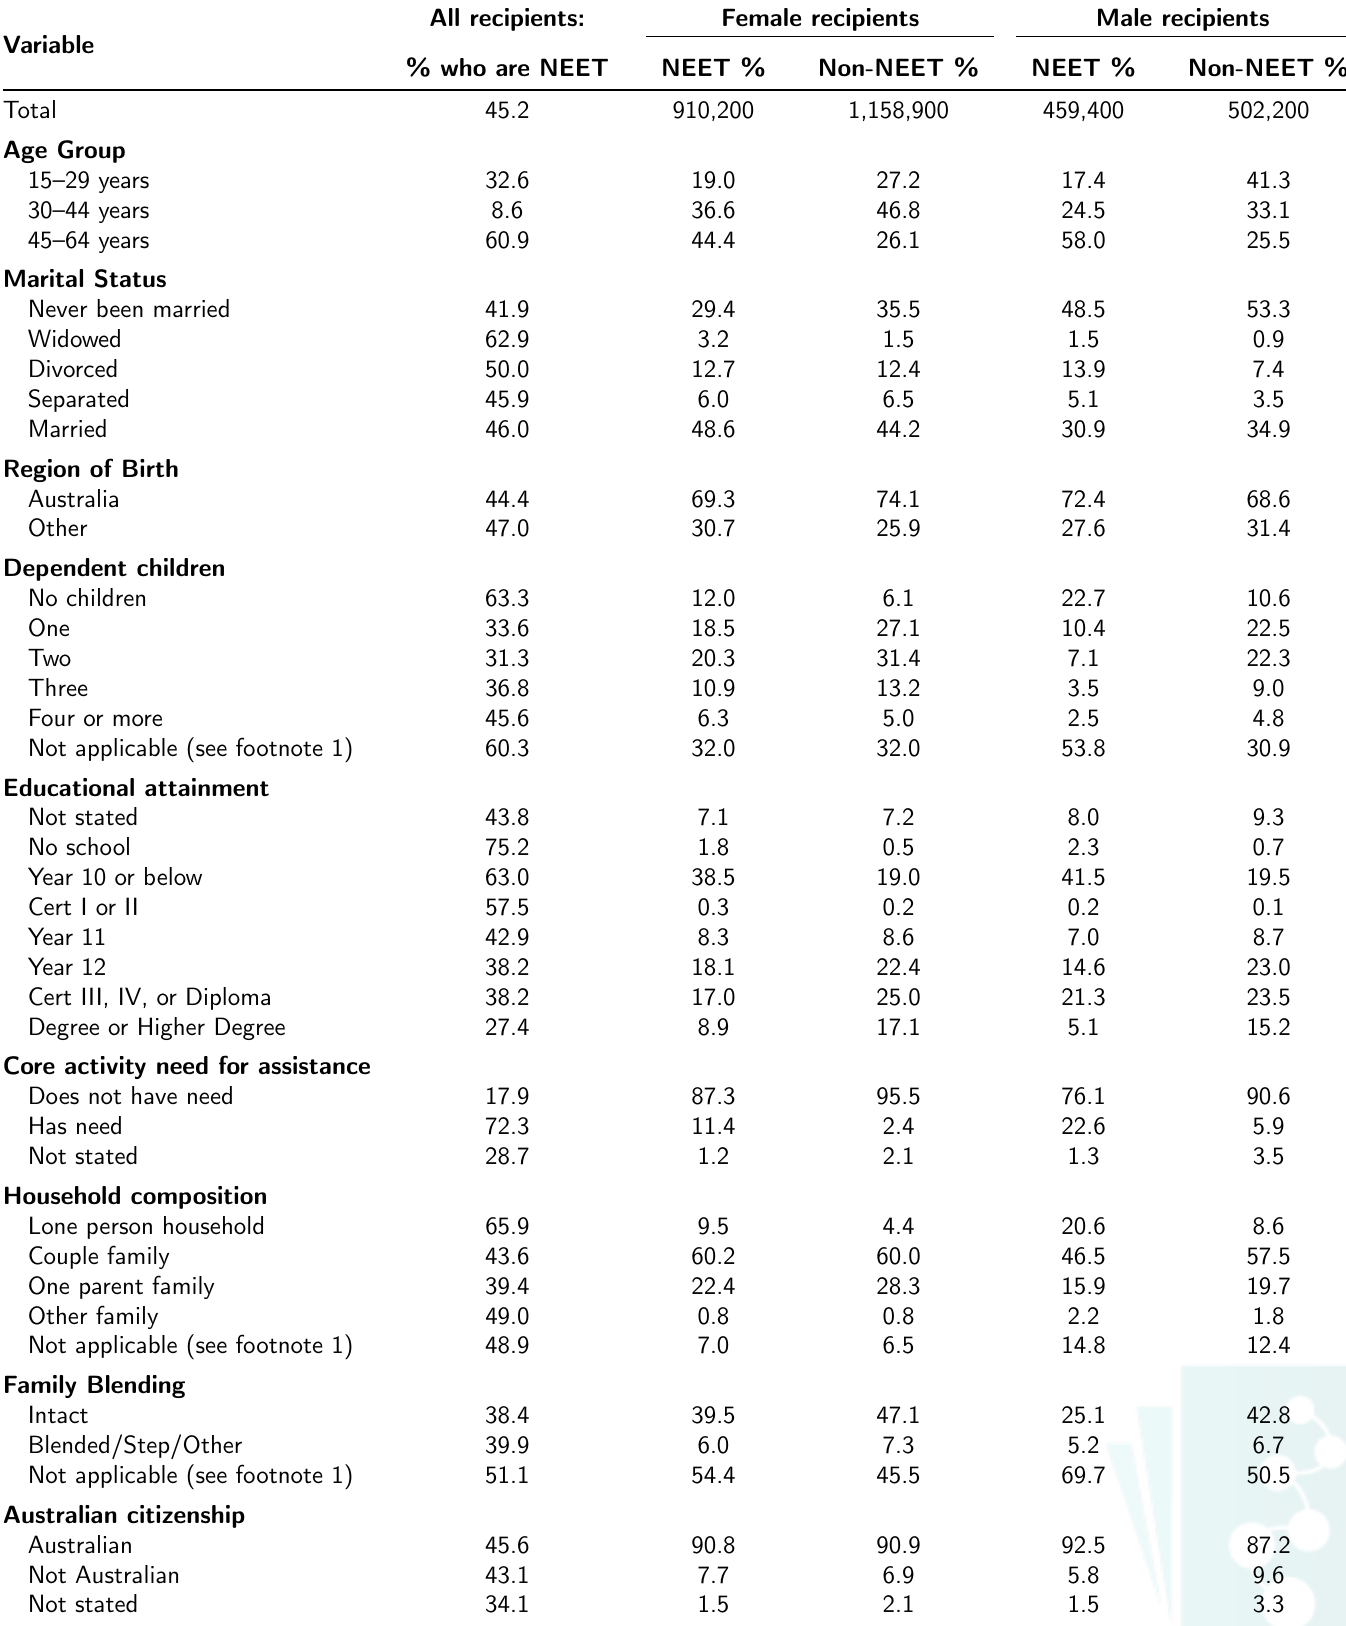
Female recipients Male recipientsAll